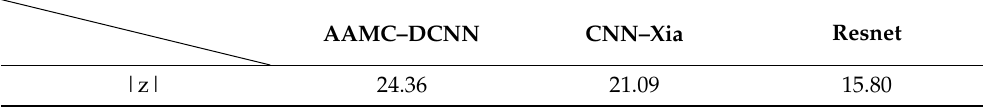
Table 14. The values of |z| with − 5 dB SNR and the sample size for each class being